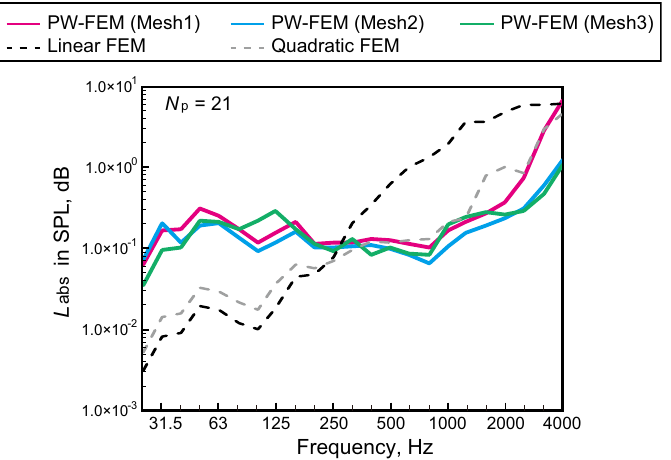
Figure 9. A comparison of the absolute errors of the PW-FEM using Mesh 1, Mesh 2, and Mesh 3 and the classical linear and quadratic